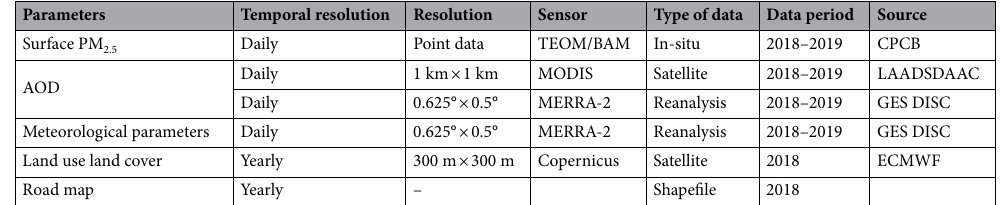
Table 1. List of all input parameters used in the statistical